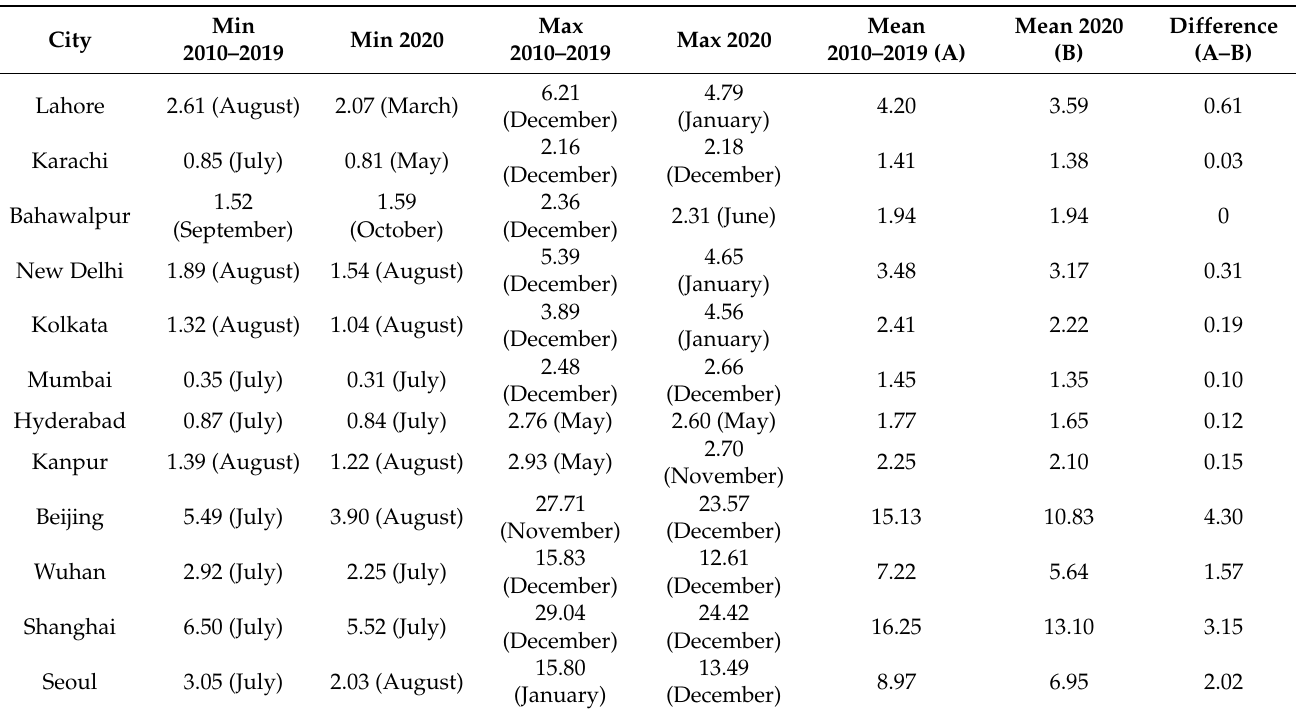
Table 2. Minimum and maximum monthly NO 2 concentrations in the 12 cities and differences before and during